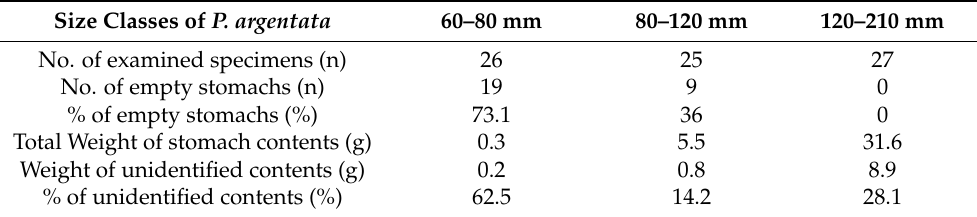
Table 2. Information regarding empty and unidentified stomach contents in P. argentata classified